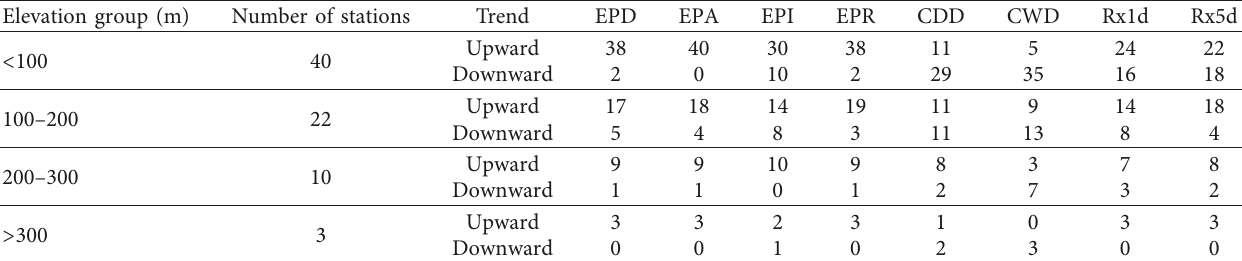
Table 7: Distribution of stations showing upward and downward trends in the categorized elevation groups.